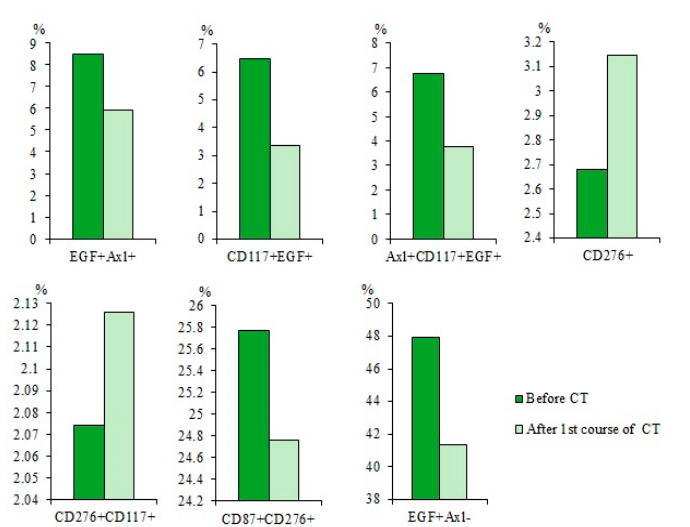
Figure 11. The content of CD87 + , CD87 + CD117 + , CD117 + Axl + EGF + CD44 + , EGF + Axl + , CD117 + EGF + , Axl + CD117 + EGF + , CD276 + , CD276 + CD117 + , CD87 + CD276 + , and EGF + Axl − CTCs in the blood of SCLC patient G before and after the first course of chemotherapy (CT) (% of all labelled mononuclear cells). Cells were analyzed by flow cytometry using antibodies for CD44, CD87, CD117, CD276, EGF, and Axl. When studying the expression of the SOX2, it was found that CT caused a significant reduction in the subpopulation of CD90 + SOX2 + CTCs (by 63%) in the blood of patient G in comparison with the values before treatment (Figure 12). At the same time, cytostatics did change the percentage of EGF + SOX2 + and CD276 + SOX2 + CTCs, while the number of CD87 + SOX2 + CTCs increased by 53%.